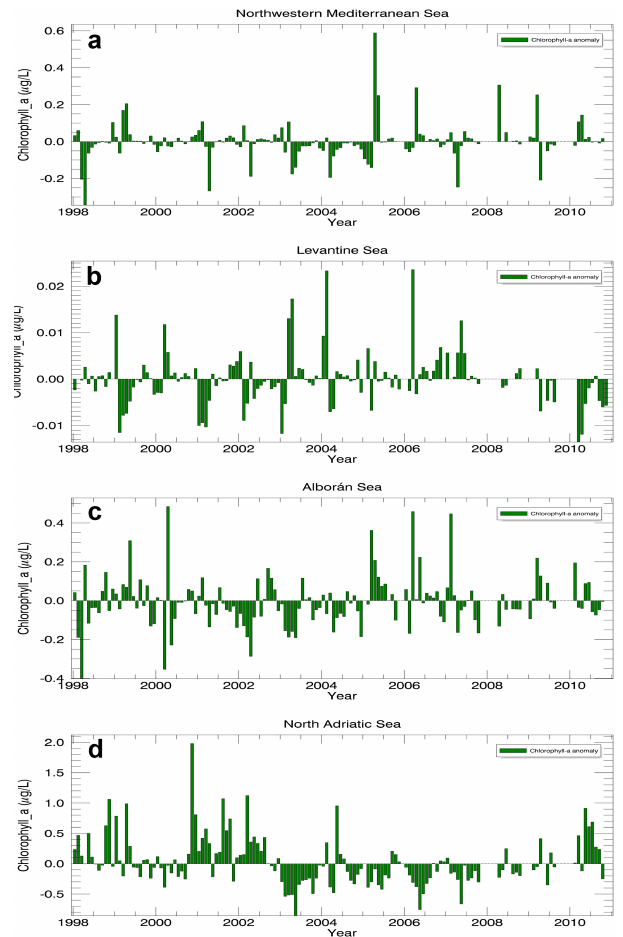
Figure 10. Monthly anomalies of TChl a computed for the entire time series (1998–2010) over each of the four sectors. Gaps in the time series correspond to months where less than 90% of the ob- servations were recorded in the region. From top to bottom there are the anomalies of TChl a in the Northwestern Mediterranean Sea (NWMed), Levantine Sea (LEV), Alborán Sea (ALB) and North Adriatic Sea